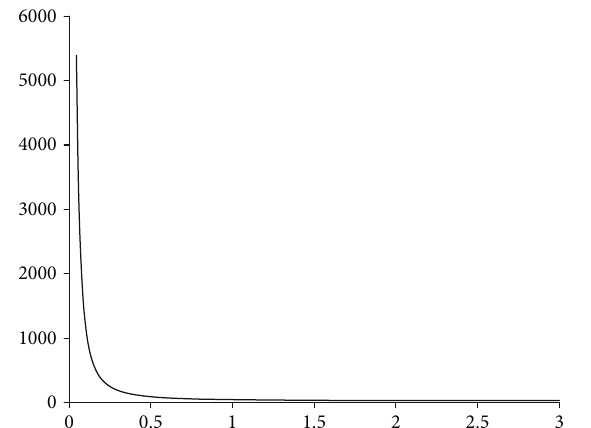
ζ Þ curve in 11 ð